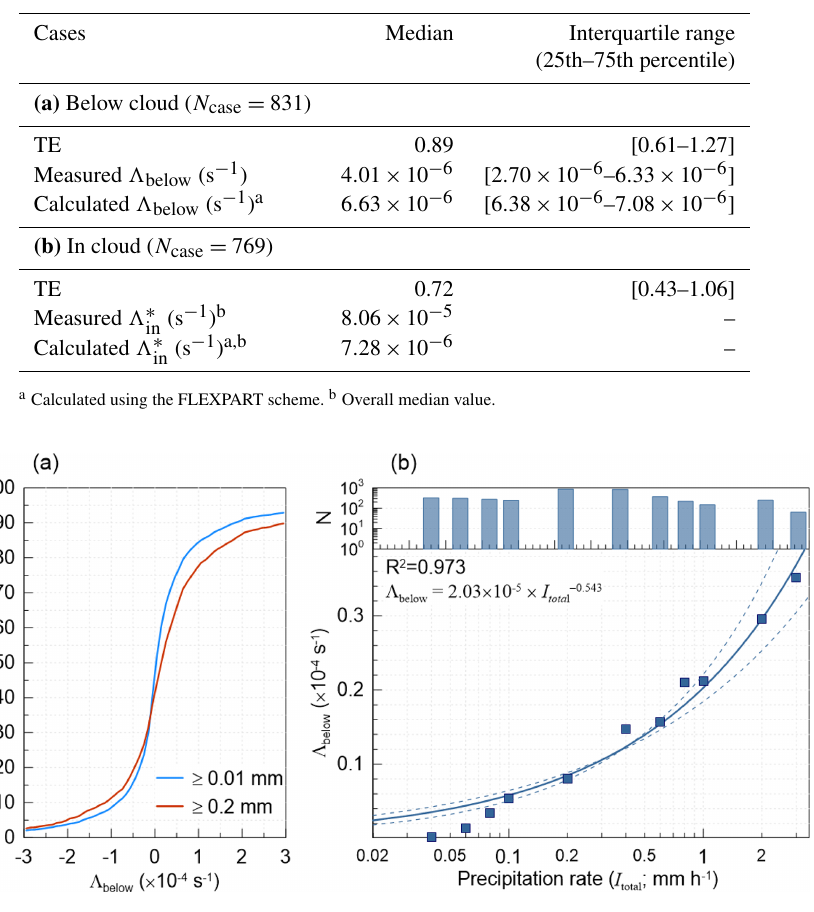
Figure 5. (a) Empirical cumulative distribution plot of measured below-cloud scavenging coefficients ( (cid:51) below ; s − 1 ), depending on the precipitation rate ( ≥ 0 . 01 and ≥ 0 . 2mmh − 1 ). (b) Median measured (cid:51) below as a function of the precipitation intensity (mmh − 1 ) of 11 bins. The dashed line indicates the fit from the equation. The upper panel of (b) shows the number of hourly data points for each bin for I total . The 11 bins consist of 0.01–0.04, 0.04–0.06, 0.06–0.08, 0.08–0.1, 0.1–0.2, 0.2–0.4, 0.4–0.6, 0.6–0.8, 0.8–1, 1–2, and 2–3mmh − 1